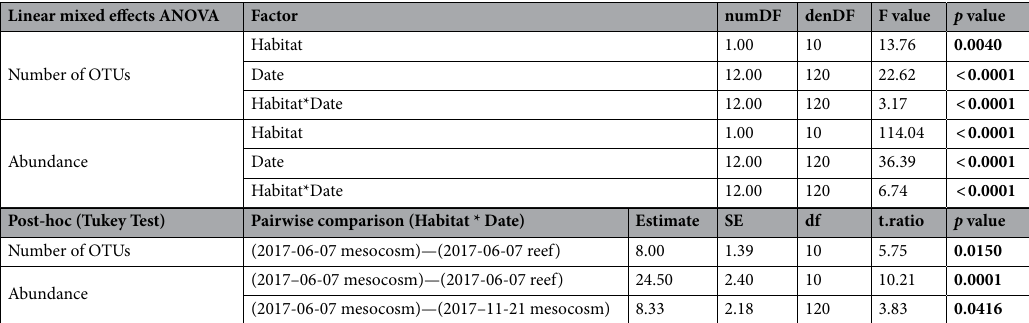
Table 2. Results of the linear mixed effects ANOVA on number of OTUs and abundance by habitat and date. Significant Tukey’s post-hoc pairwise comparisons between habitat and date for peak and minimum recruitment are presented. All pairwise comparisons can be found in Supplementary Table S3 and S4. Significant values are in